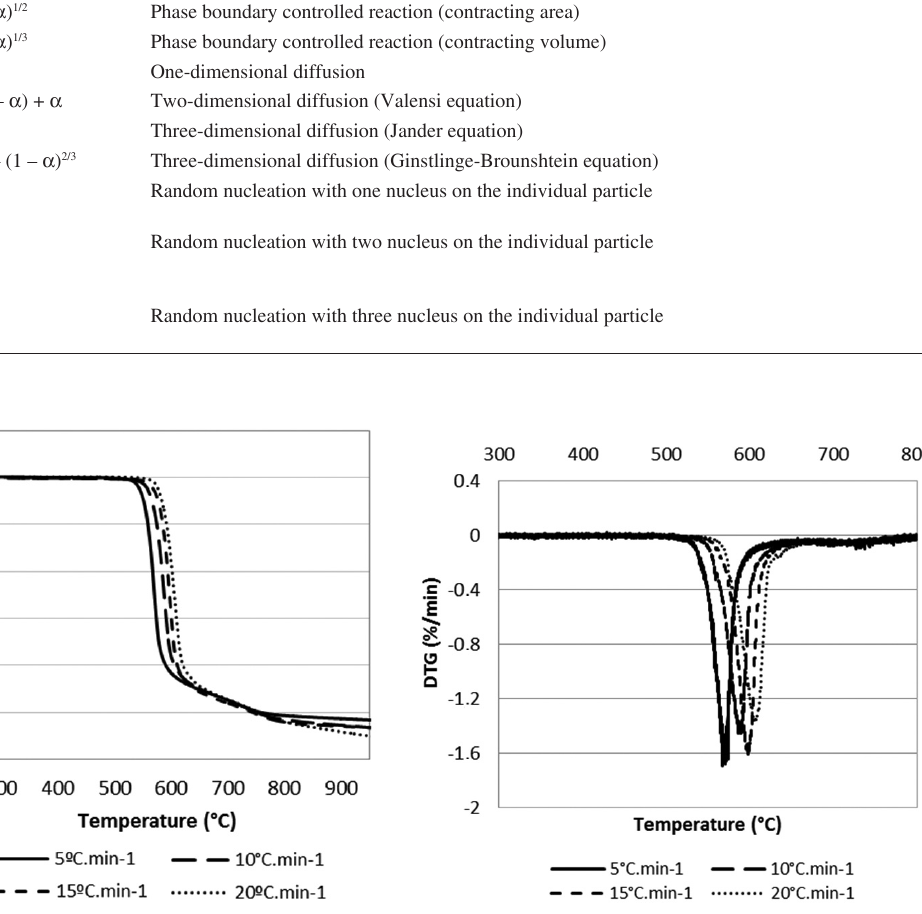
Figure 2. DTG curves of PEEK in nitrogen atmosphere for the heating rates of 5 °C.min –1 ; 10 °C.min –1 ; 15 °C.min –1 and 20 °C.min –1